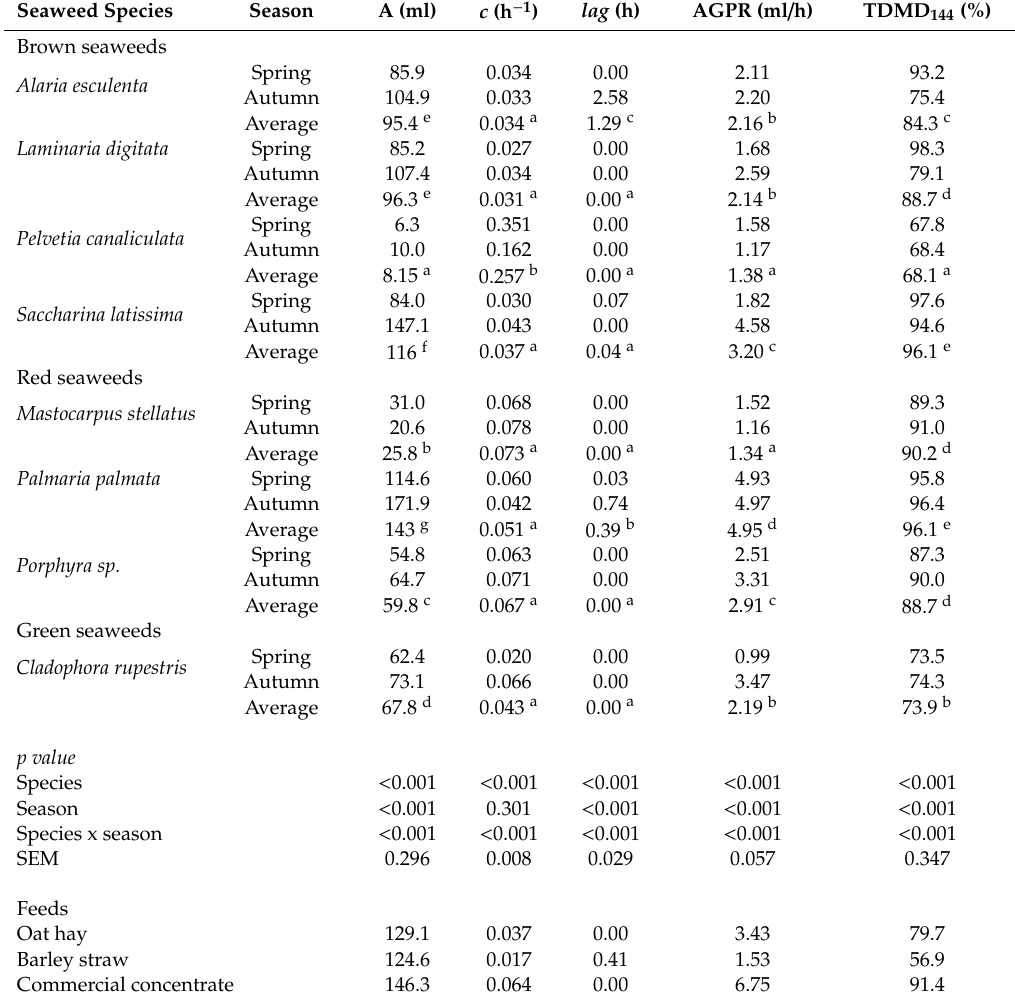
Table 3. Parameters of gas production kinetics (A, c, lag and AGPR) and true dry matter (DM) digestibility (TDMD 144 ) after 144 h of in vitro incubation of di ff erent seaweed species harvested in spring and autumn in northern Norway and of feeds commonly used in ruminant diets 1